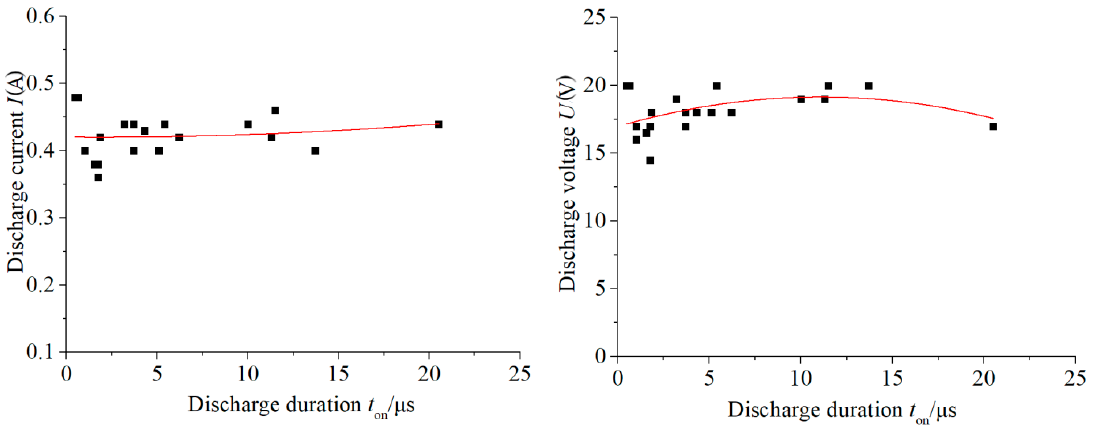
Figure 4. E ff ect of the discharge duration on the discharge current and